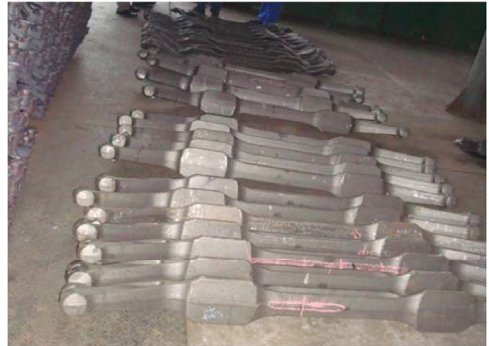
Figure 1: Crack samples.